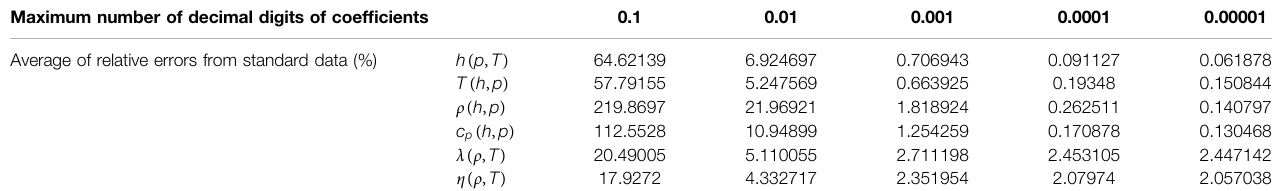
TABLE 13 | Average of relative errors between standard data and the fi tted models with different maximum number of decimal digits. Maximum number of decimal digits of coef fi cients